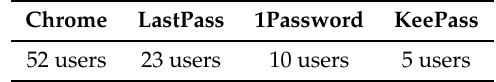
Table 25. Analyzing 4 different password managers (number of users for each